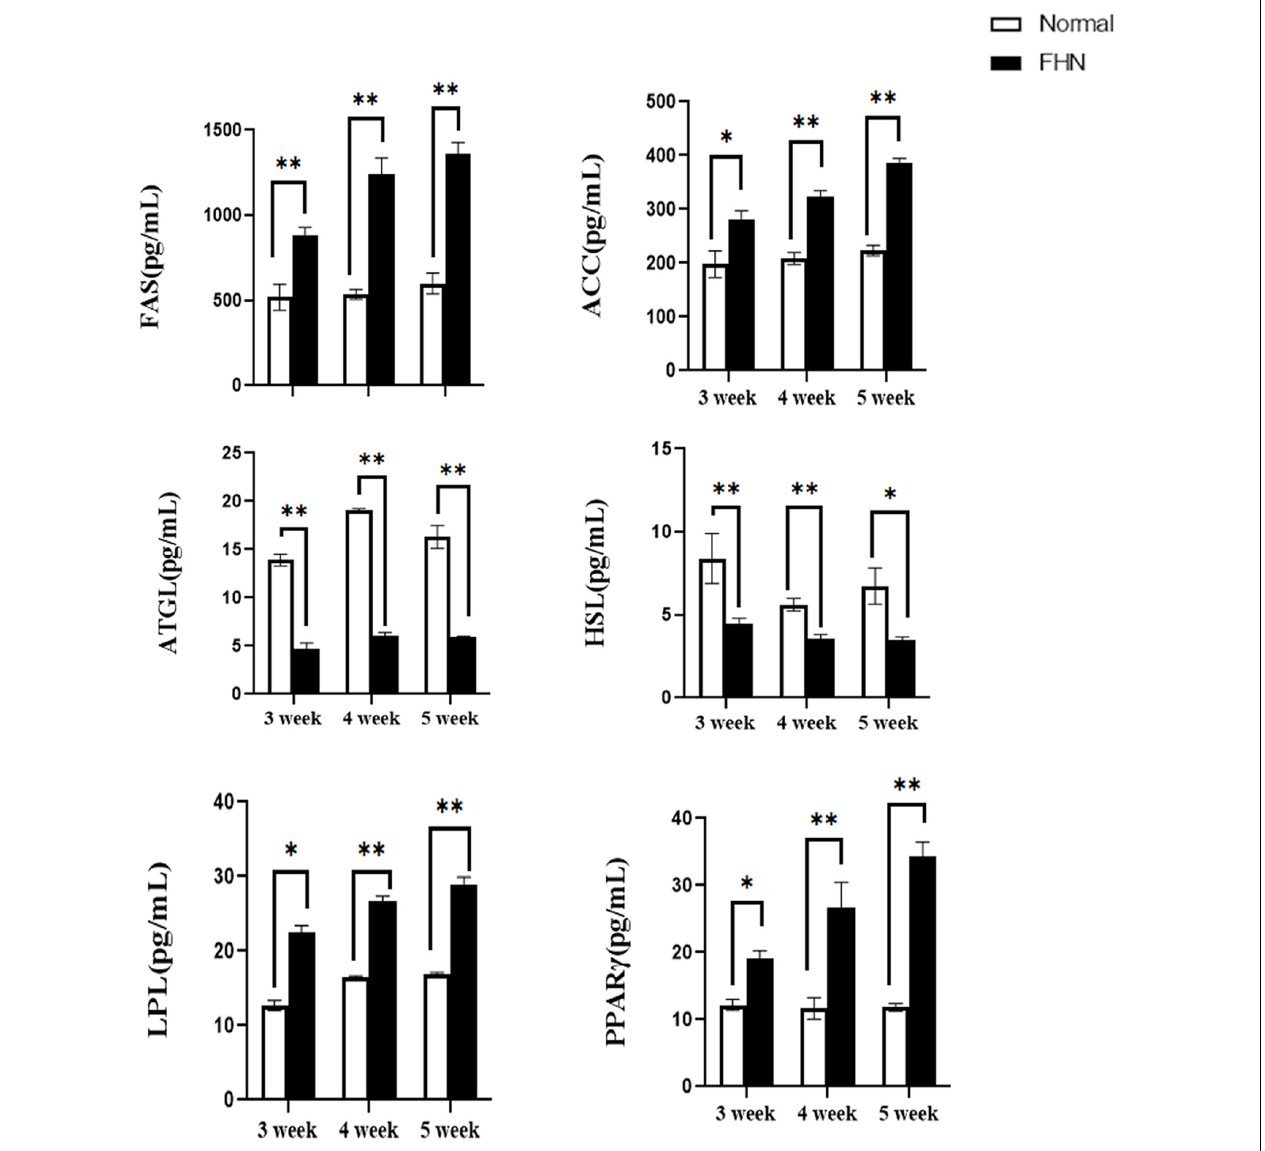
FIGURE 8 | The changes in serum lipid metabolism-related enzymes and markers. ∗ indicates a significant difference ( P < 0.05). ∗∗ indicates an extremely significant difference ( P <